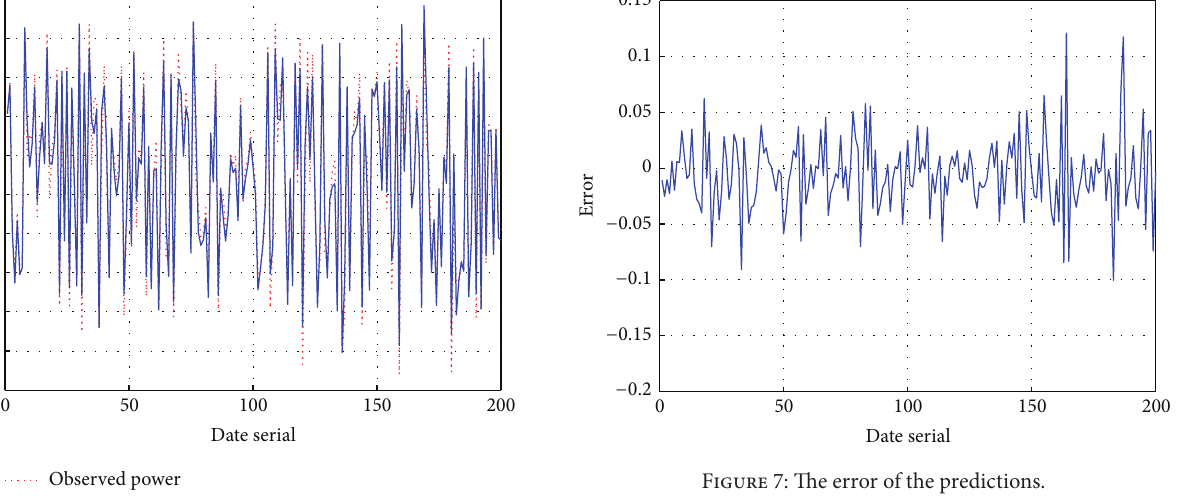
Figure 7: The error of the predictions.